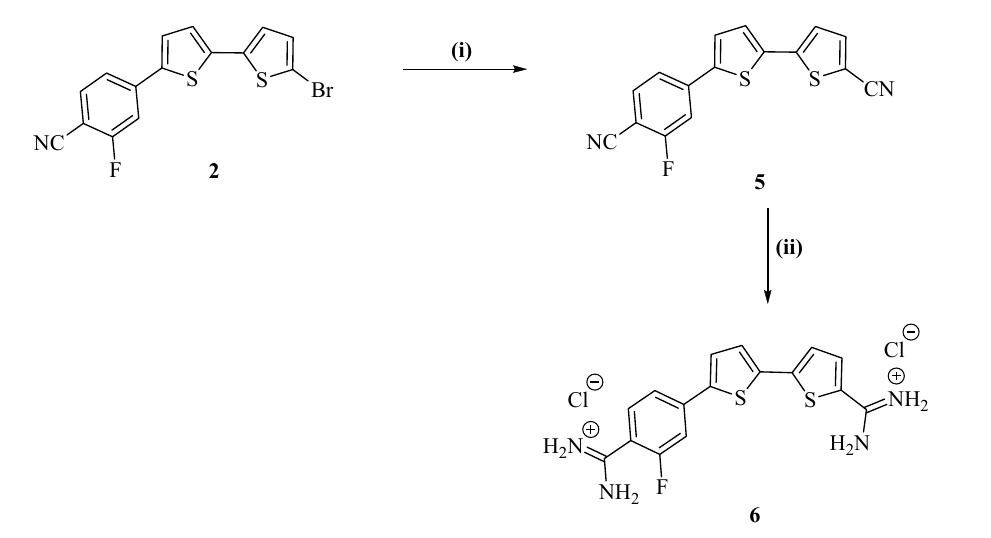
Figure 2. Synthesis scheme for dicationic bithiophene-5-carboxamidine derivative 6